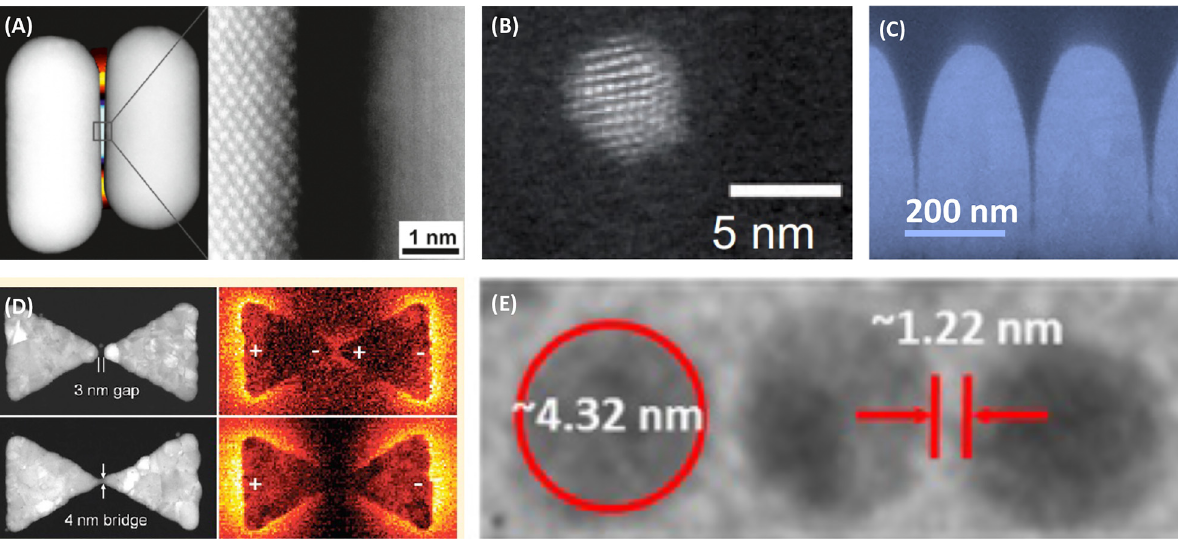
Figure 3: Selection of scanning transmission electron microscopy images of plasmonic nanostructures, all with a common feature of exhibiting true nanoscale features. (A) Gold nanoparticle dimer exposing a nanogap (left) and with clear indications of the atomic columns (right). Figure adapted from Ref. [123] ( © 2012 American Chemical Society). (B) Silver nanoparticles with a clear indication of the atomic columns. Figure adapted from Ref. [124]. (C) Steep and narrow nanogrooves in the gold surface. Figure adapted from Ref. [125]. (D) Gold bow-tie antennas with nanogaps. Figure adapted from Ref. [126] ( © 2012 American Chemical Society). (E) An array of gold nanoparticles with nanogaps. Figure adapted from Ref. [127] ( © 2017 American Chemical